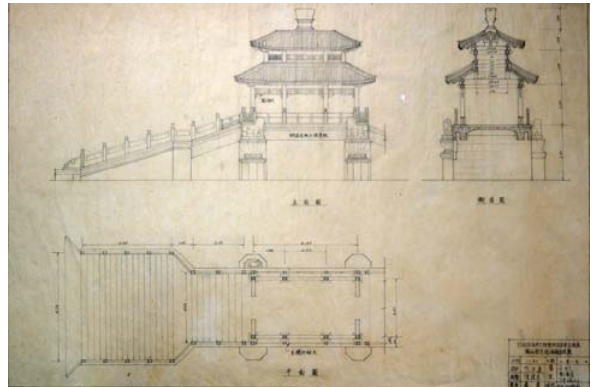
Fig. 5. A survey drawing of Xing Bridge 荇桥 , 1948 (From: Chinese Academy of Cultural Heritage)